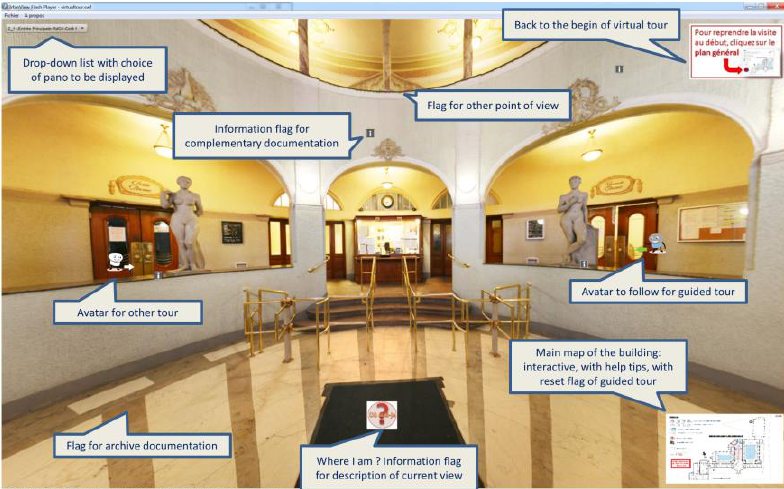
Figure 12: Main entrance of baths of Strasbourg with tags and different options for navigation and